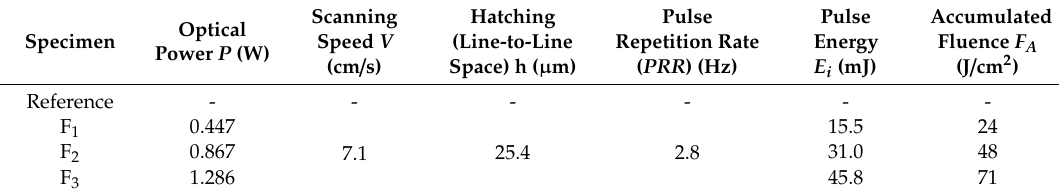
Table 1. Process parameters for CO 2 laser surface treatments of PLLA